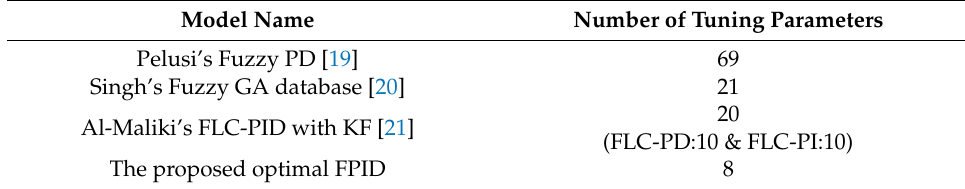
Table 9. Number of tuning parameters for different